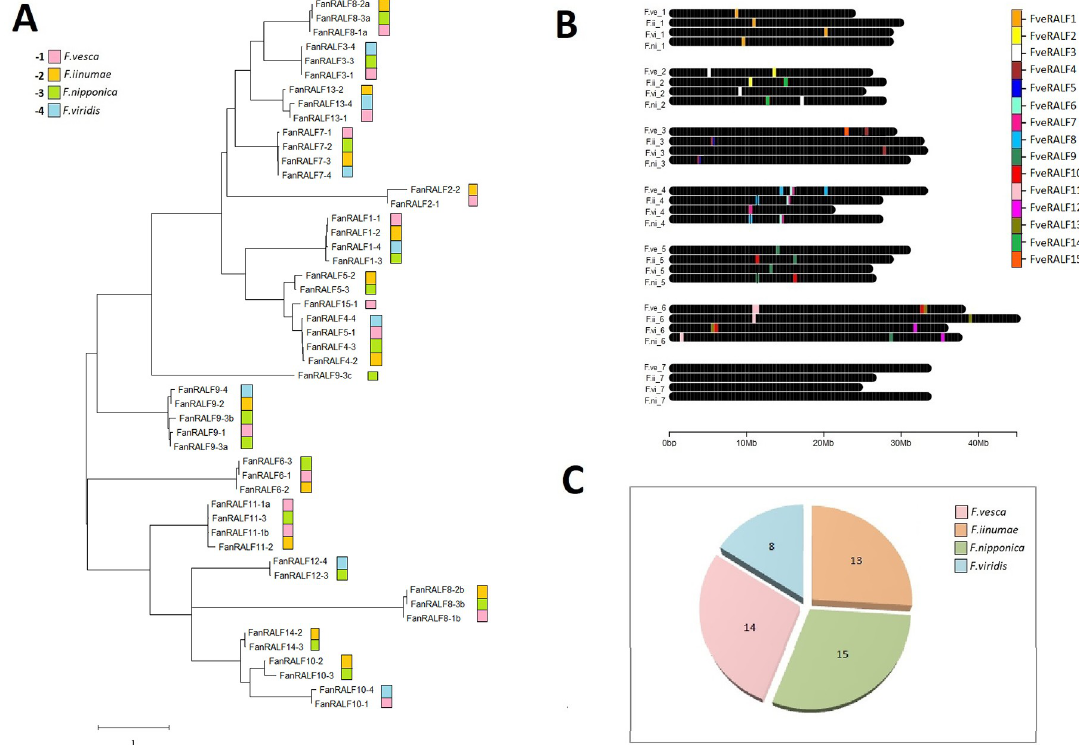
Fig 1. Fragaria x ananassa (Fxa) RALF genes phylogentic analysis, evolution and chromosome organization. (a) Phylogenetic tree was built aligning 50 Fan RALF protein sequences using MUSCLE. The tree is drawn to scale, with branch lengths measured in the number of substitutions per amino acidic site in the protein sequences. Gene annotations refer to F . × ananassa cv . Camarosa v1.0.a1 and are listed in S1 Table. Progenitor lineage were inferred from gene chromosome location (b), and pink was used for F . vesca subgenome, green for F . nipponica , light blue for F . viridis and orange for F . iinumae . The color legend also reports the code number used to name different FanRALF genes according to subgenome lineage, as is reported in S1 Table. (b) FanRALF genes chromosome spatial organization in the octoploid genome. (c) Pie chart showing total FanRALF gene members present in the four subgenomes.